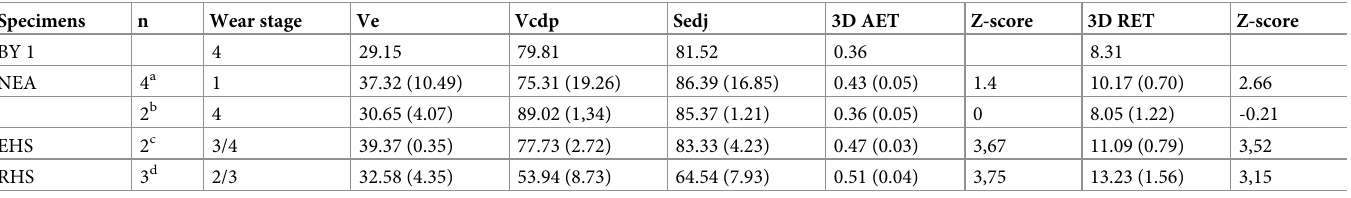
Table 2. Values of the components of enamel thickness computed for Neanderthal (NEA), early Homo sapiens (EHS) and recent Homo sapiens (RHS) lower decid- uous canines at different wear stages (ws).